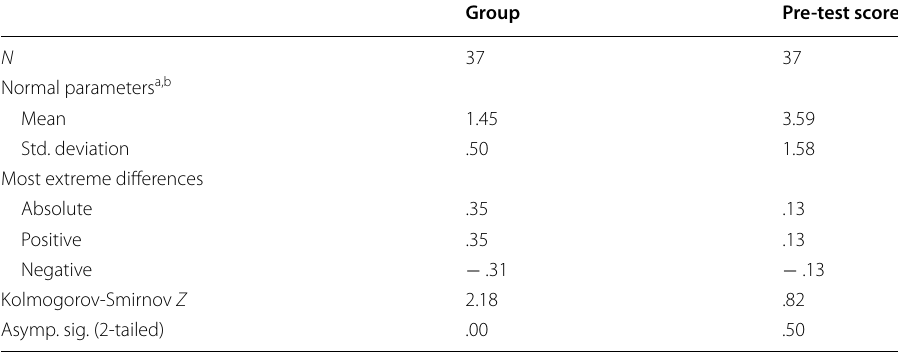
a Test distribution is normal b